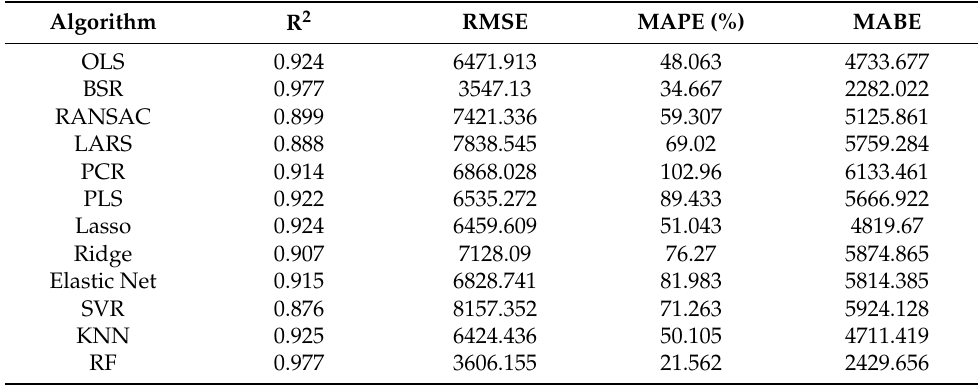
Table 5. Model training results through 10-fold